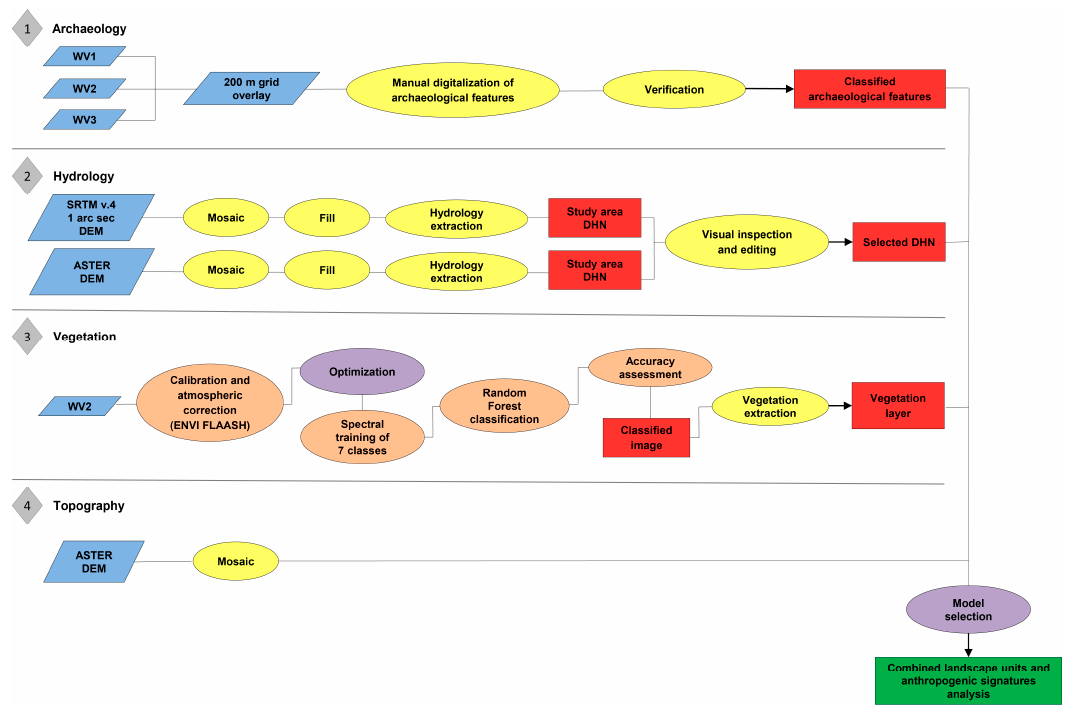
Figure 1. The schematic GIS workflow used in this study. Blue boxes include types of satellite imagery. Processing steps are in ovals, representing ArcGIS processing (yellow), ENVI processing (orange) and R processing (purple). Red boxes feature the output datasets. The green box represents the final output.